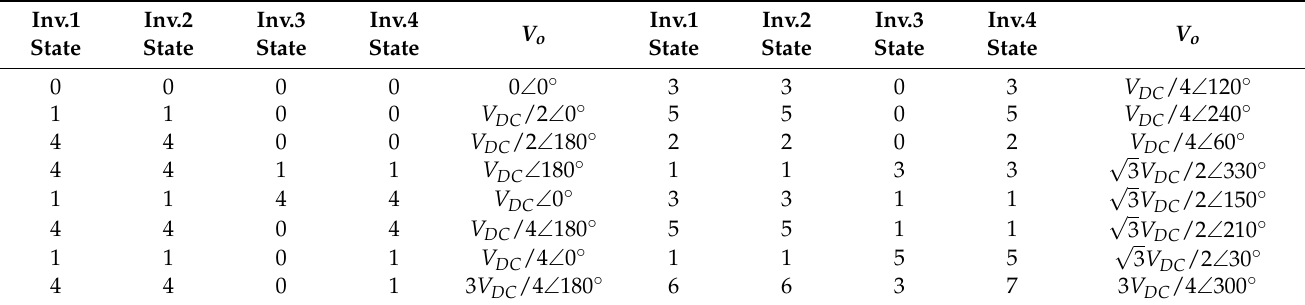
Table 2. Voltage vectors for zero common-mode voltages.